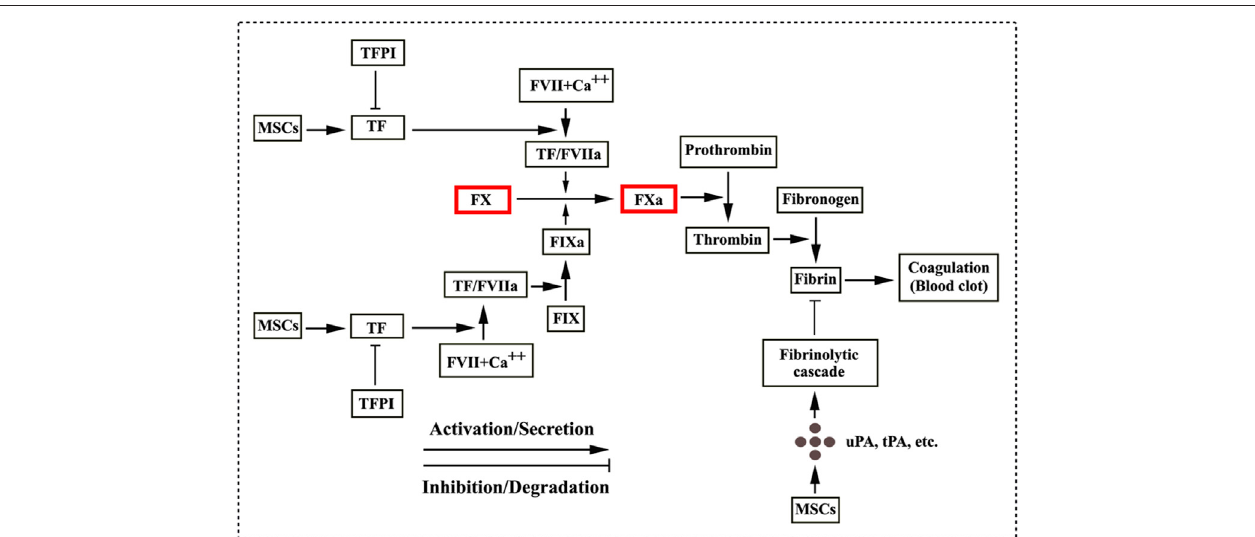
FIGURE2| MSCsinvolved incoagulation and fi brinolyticcascade. MSCs/MSC-derivedextracellularvesiclesrelease tissue factor(TF) thatinitiatesthecoagulation cascade through forming a complex of TF/FVIIa. The TF/FVIIa complex converts FX to its active form FXa and FIX to FIXa (Witkowski et al., 2016; George et al., 2018). Subsequently, a coagulation cascade proceeds as a series of proteolytic reactions. FXa catalyses the conversion of the inactive plasma prothrombin to its active form thrombin,whichinturnconvertsplasma fi brinogeninto fi brin.Treadsof fi brintrapredbloodcellstoformbloodclots.TFactivityisregulatedbyTFpathway inhibitor (TFPI) (Morrissey, 2001; Adams, 2012; Zelaya et al., 2018), seeming to be potentially effective in decreasing thrombosis. MSCs are also involved in the fi brinolytic cascade by the secretory production from MSCs such as the urokinase plasminogen activator (uPA), the tissue plasminogen activator (tPA) and the plasminogen activator inhibitor in context of pathological conditions (Neuss et al., 2010; Acosta et al., 2013).